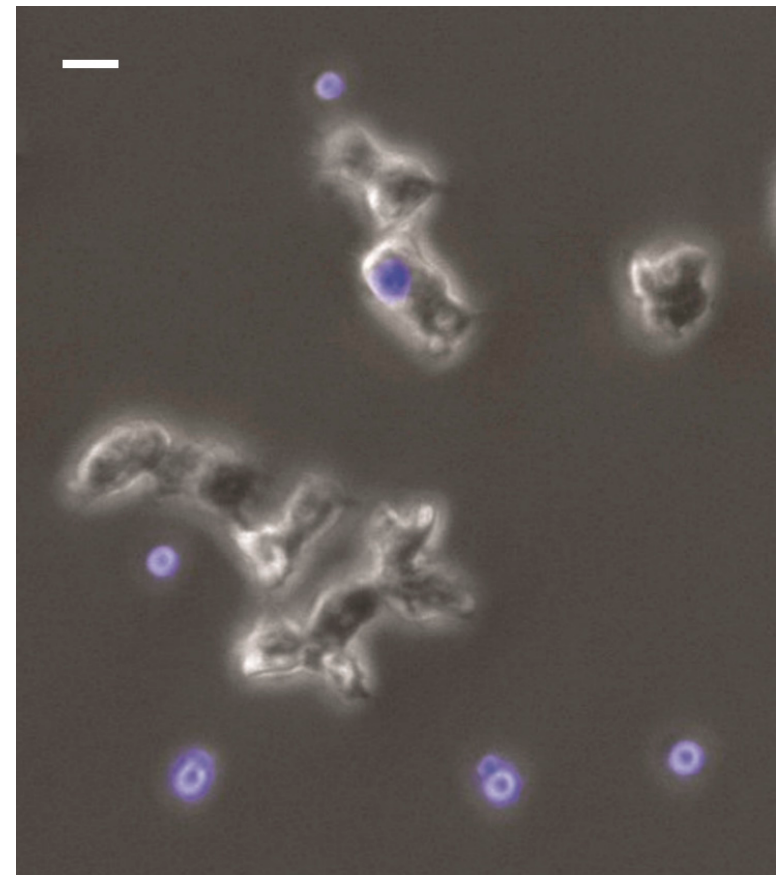
Figure 1. Interaction of C. neoformans (blue) with Acanthamoeba castellanii . The amoeba are much larger than the fungal cells and readily ingest them. The amoeba in the top middle center has ingested a fungal cell. For details of the conditions in this experiment see [45]. Briefly, A. castellanii and C. neoformans cells were incubated in a 8-well-chambered cover glass. Fungal cells appear blue because theys were stained with 0.01% Uvitex 2B prior to co-incubation. Images were taken using a DAPI (4 ′ ,6- diamidino-2-phenylindole) filter-equipped Zeiss Axiovert 200M inverted microscope with 20× phase objective.